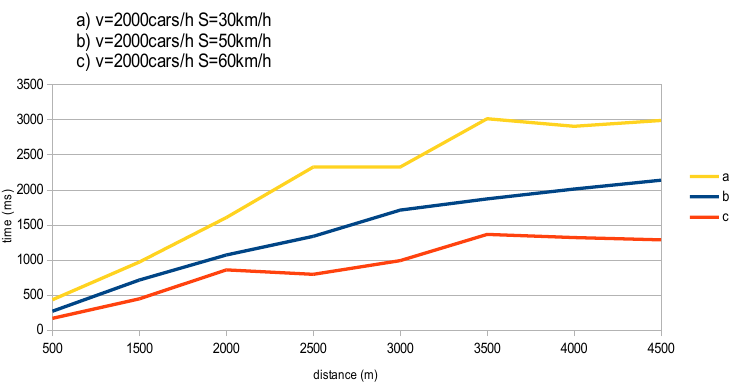
Figure 4. Packet delivery time with the distance between roadside unit RSU stations for scenario (A).